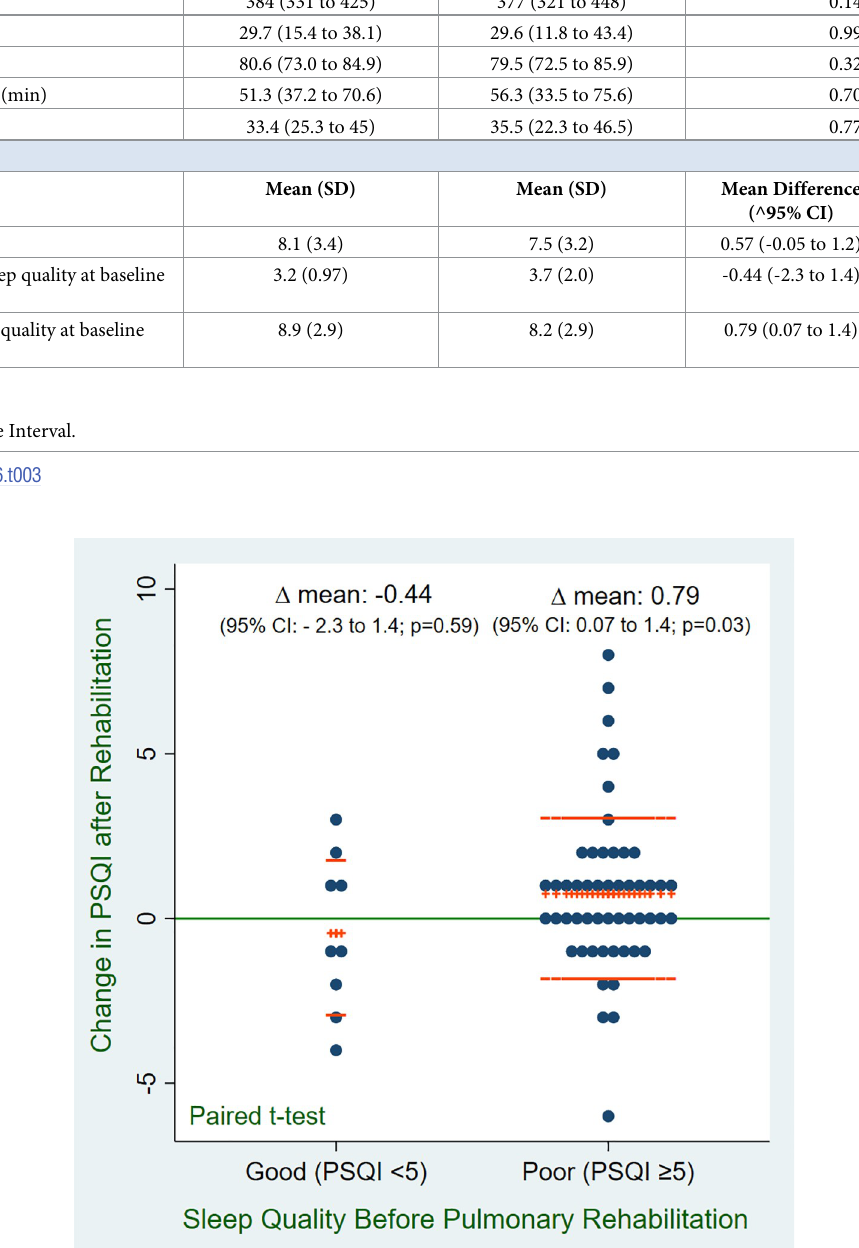
Fig 2. Effect of PR in PSQI score in veterans with good sleep quality (PSQI < 5) and poor sleep quality (PSQI � 5). Data are presented in mean change in PSQI among veterans with good sleep quality and poor sleep quality before and after PR. The line (+++) shows mean change and the line (—) shows data dispersion with ± 1 standard deviation (SD). Abbreviations: PSQI, Pittsburg Sleep Quality Index; CI, Confidence